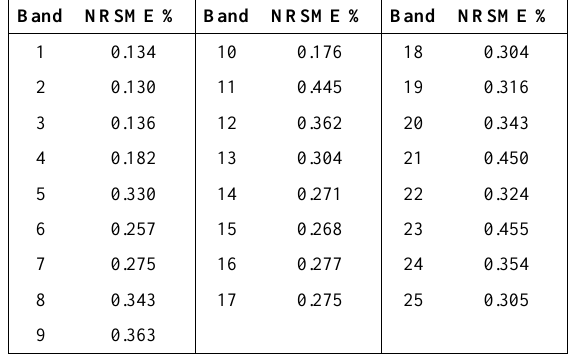
Table 2. NRMSE% obtained from the radiometric resolution